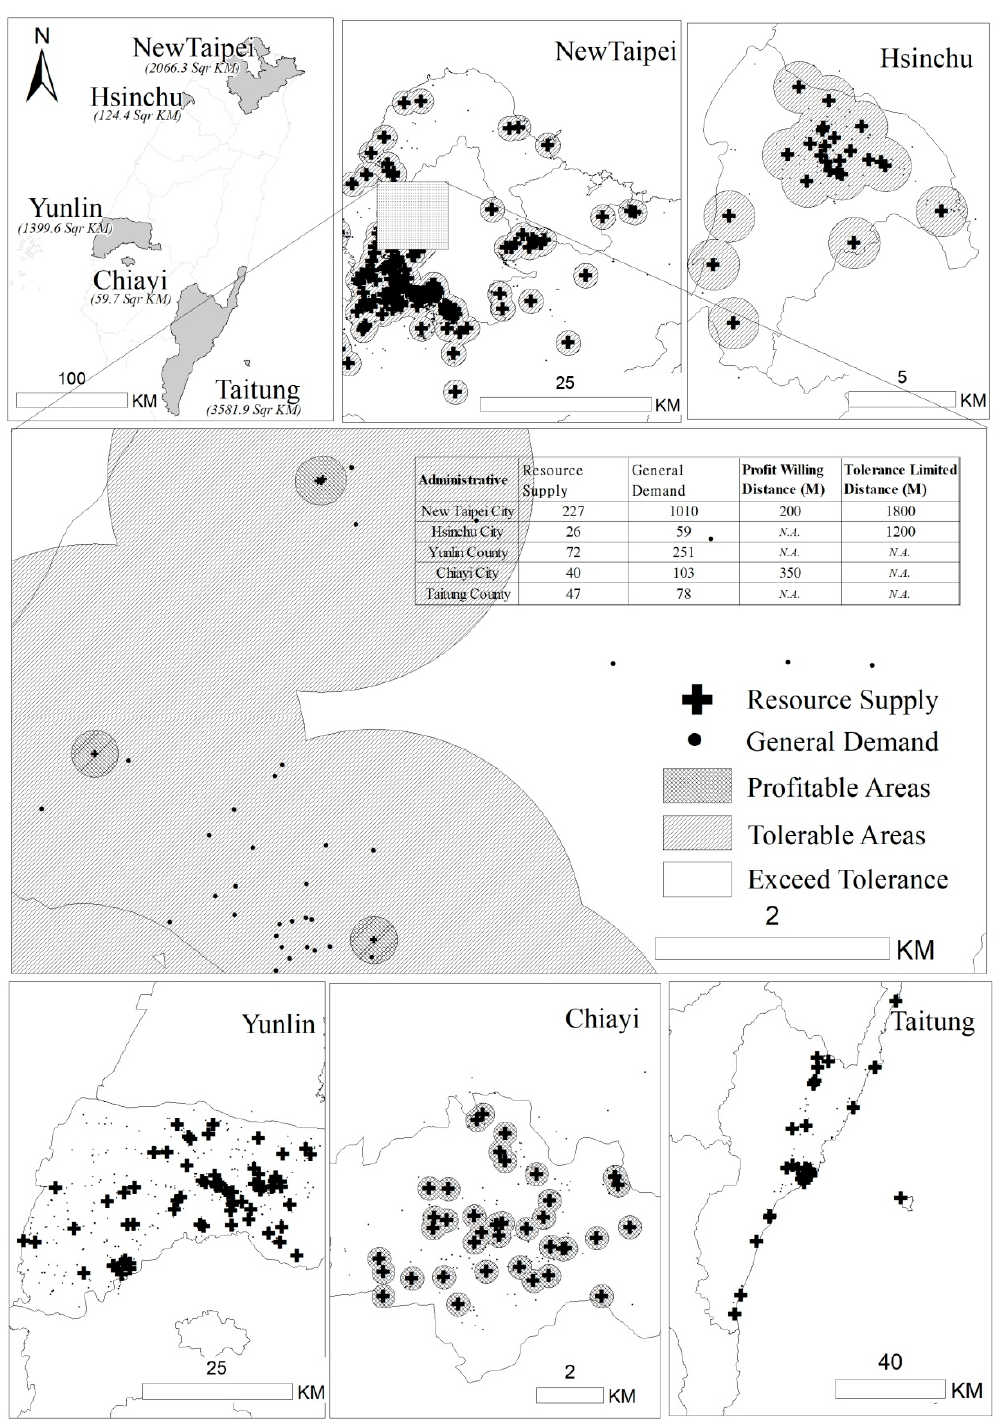
Figure 3. Schematic diagram of different situations of PWD and TLD: taking five cities and counties as examples.